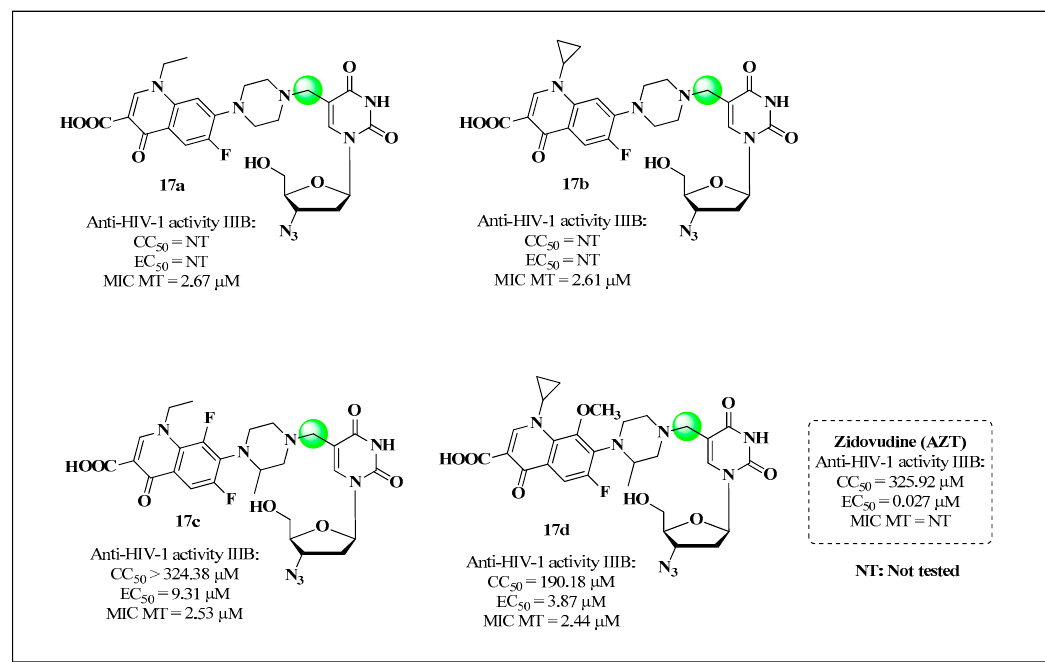
Figure 16. Compounds 17a – d and their anti-HIV and anti-MTB activities reported by Senthilkumar and collaborators in 2009 [94].